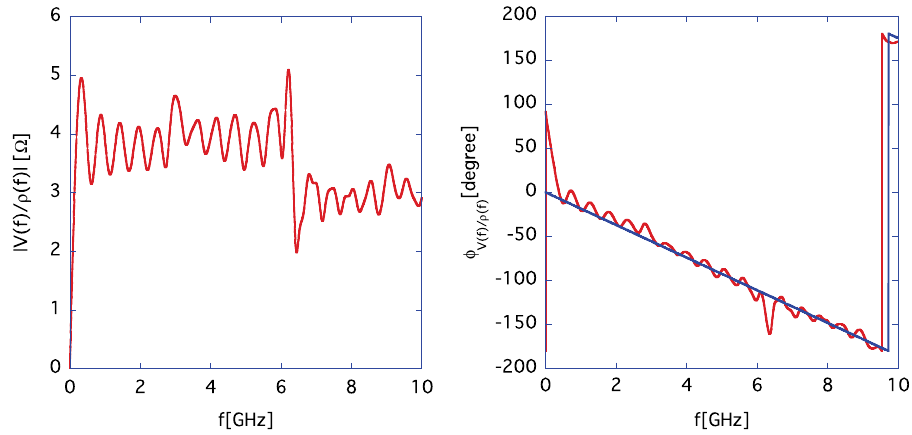
FIG. 12. The simulation results for a 1 ¼ 40 mm chamber housing the triangle electrodes with